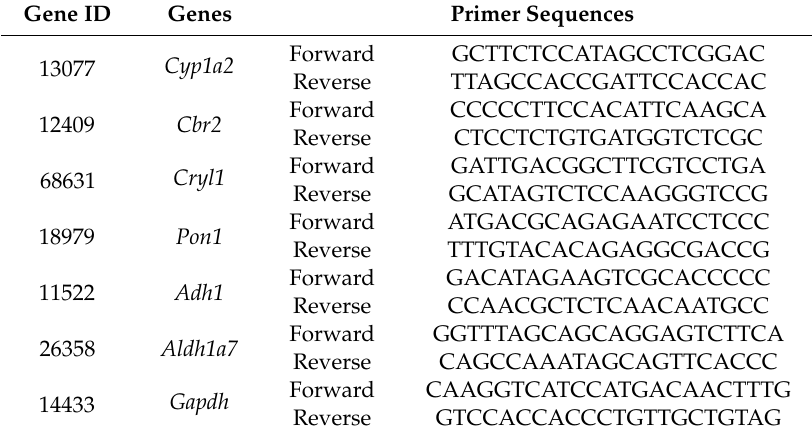
Table 1. List of primers used for